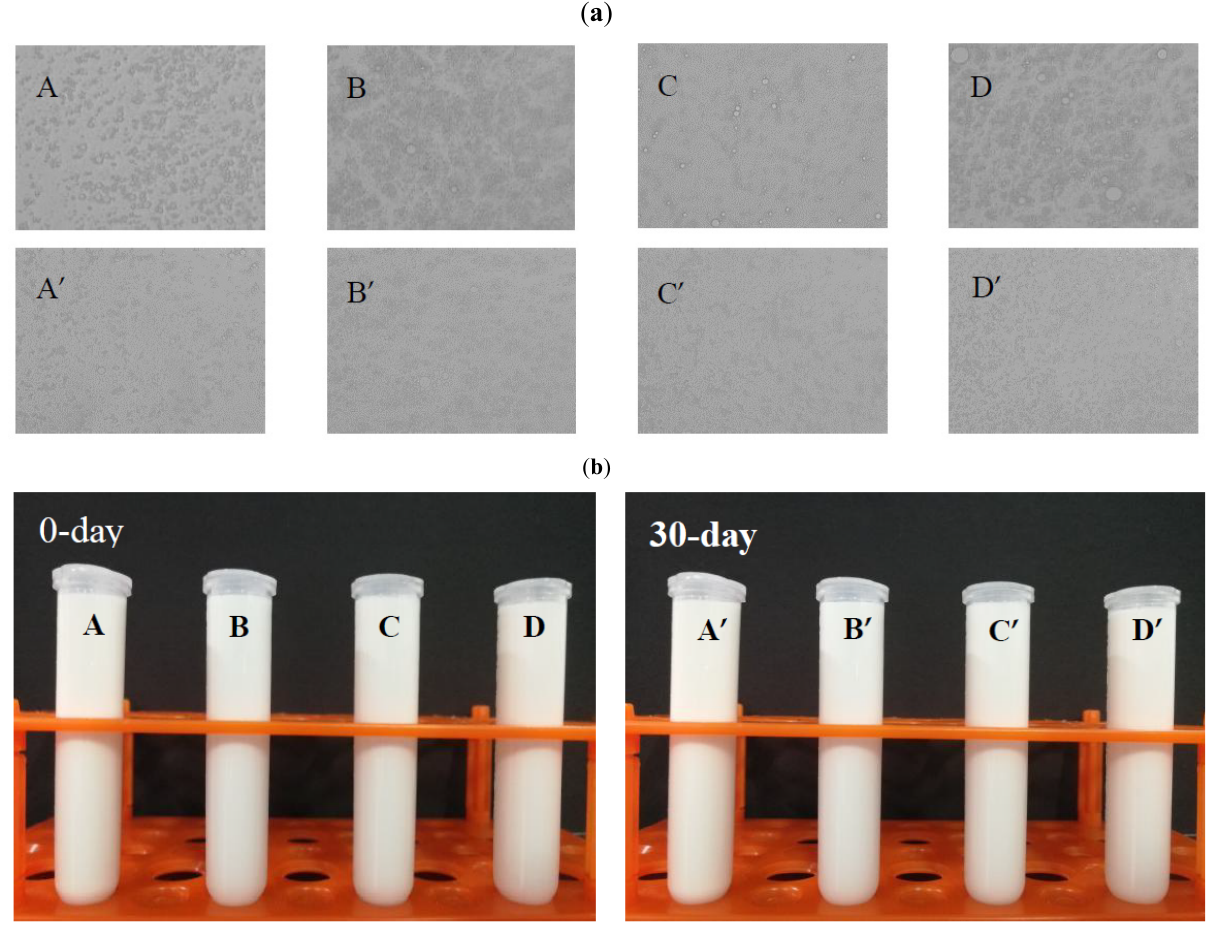
Figure 8. ( a ) Light micrographs of emulsions prepared by different extraction methods on day 0 and day 30 of storage (40 × ). ( b ) Stability of the O/W emulsions prepared by different extraction methods on day 0 and day 30 of storage. (A and A’: HHPCP; B and B’: HHPHP; C and C’: CCP; D and D’: CHP).